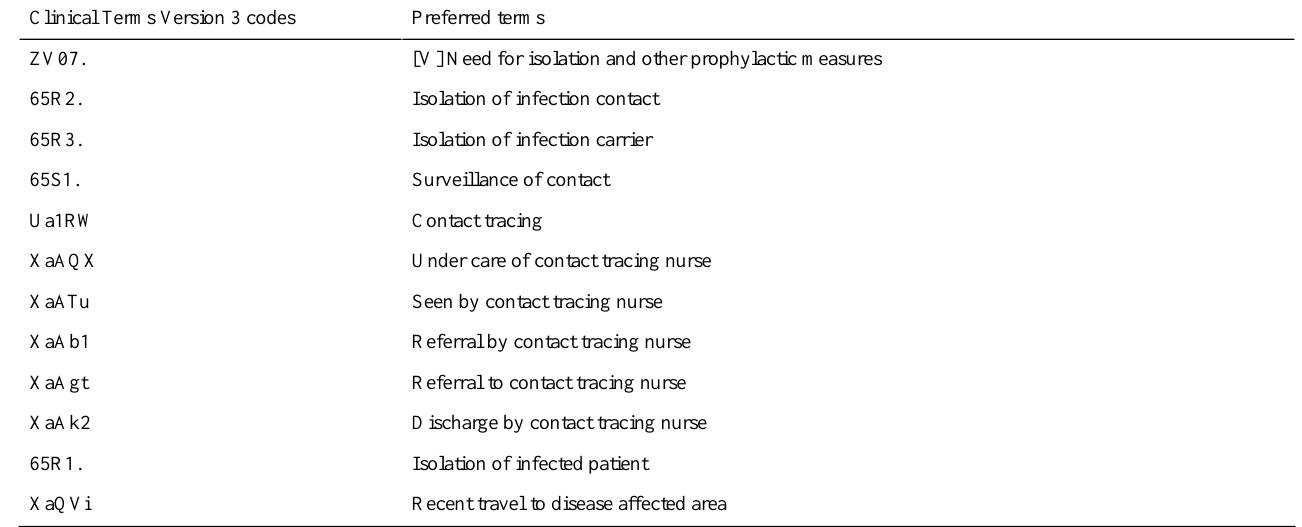
Table 3. Clinical Terms Version 3 codes to flag control measures and audit their